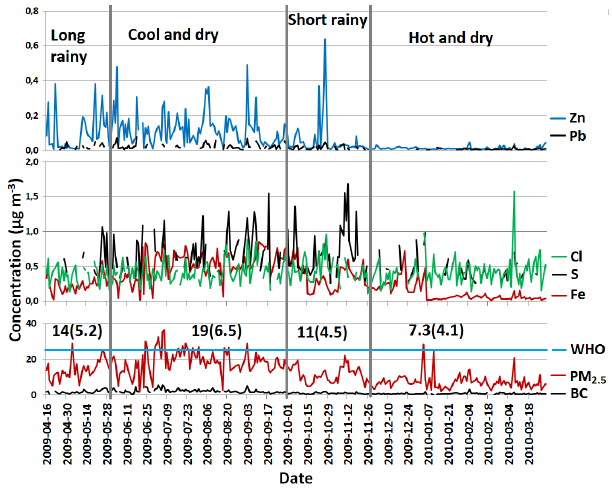
Figure 5. Seasonal variation of PM 2 . 5 and some elements sampled at the UNEP site. Included in the figure are the seasonal averages and standard deviations (enclosed in parentheses) as well as the World Health Organization air quality guideline for a 24h